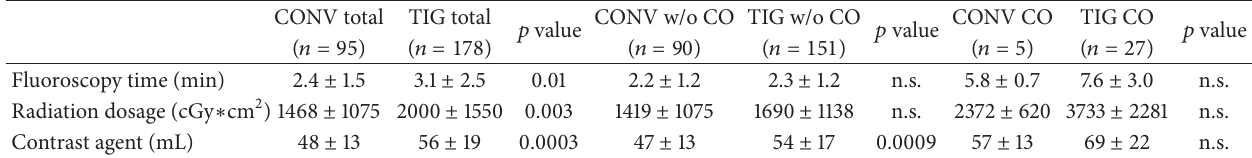
Table 2: Fluoroscopy time, dosage, and contrast medium for CONV versus TIG catheters.